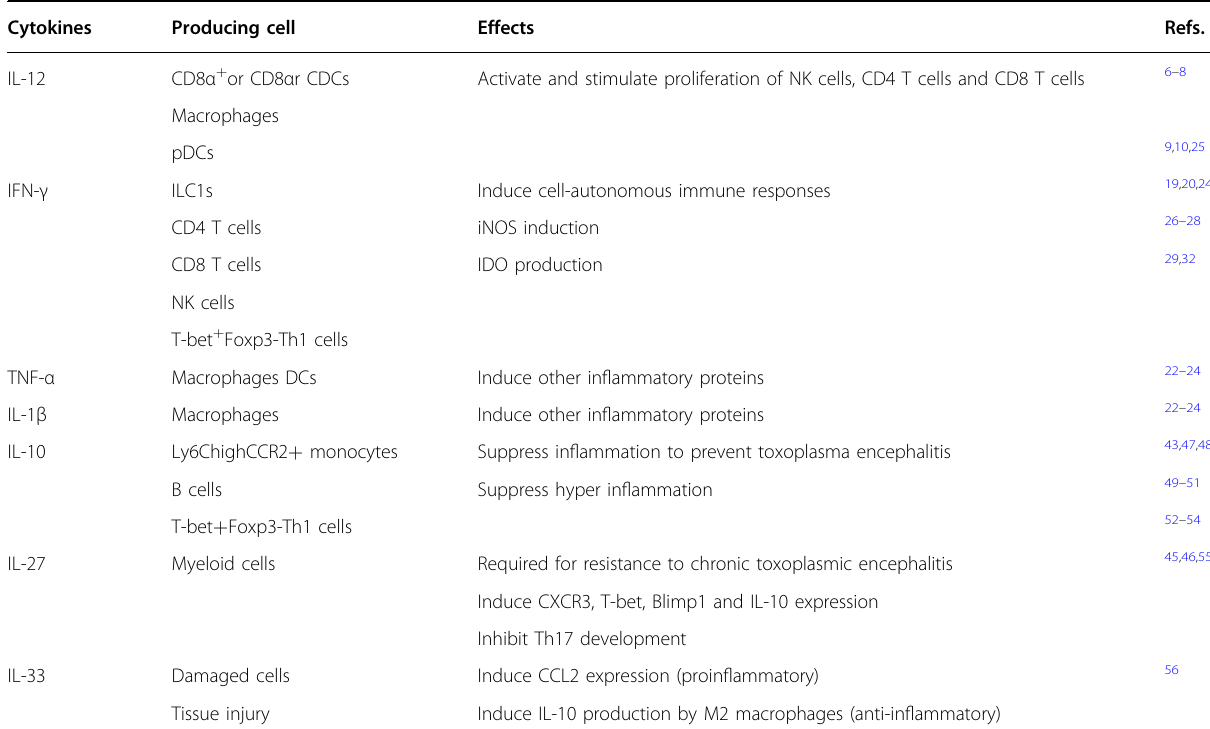
Table 1 List of major cytokines that are produced by T. gondii infection and the effect of each cytokine. Cytokines Producing